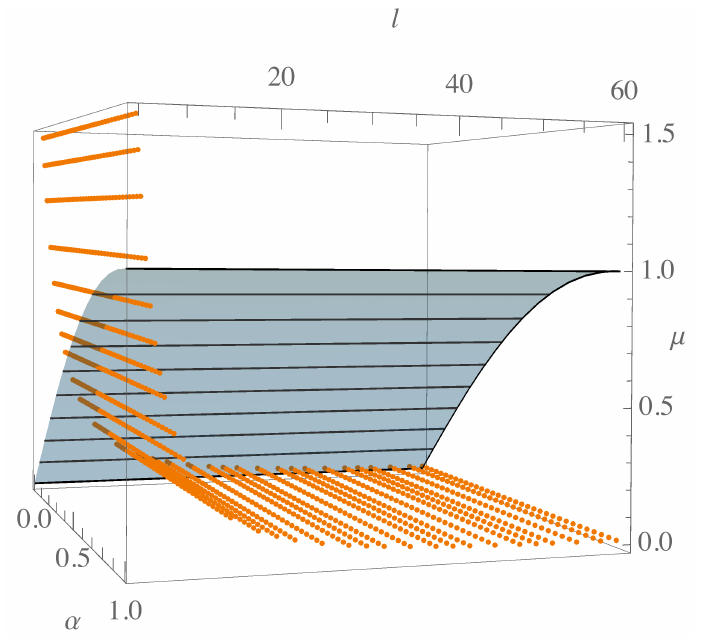
Figure 4. Alternative point of view of the intersection of the surfaces µ c and µ α